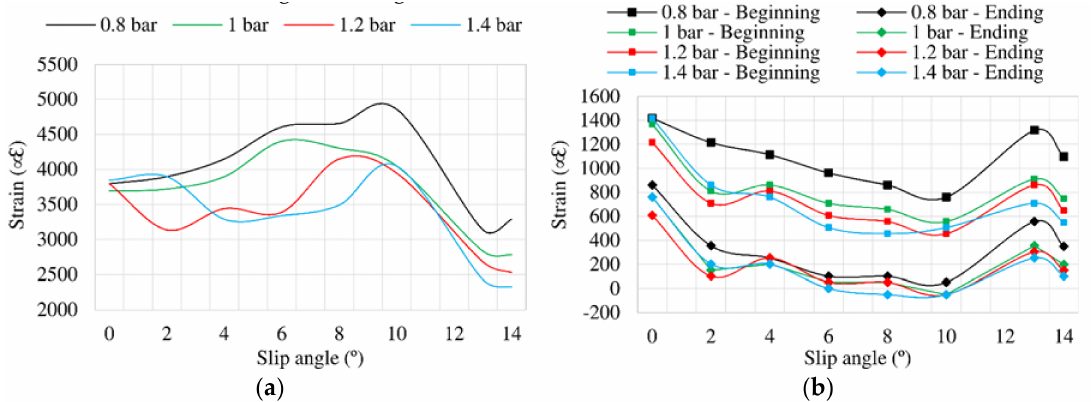
Figure 11. ( a ) Maximum strain peaks in channel 2 ( ε x ) at 750 N, 50 km/h; ( b ) Maximum strain peaks in channel 3 ( ε y1 ) at 750 N, 50